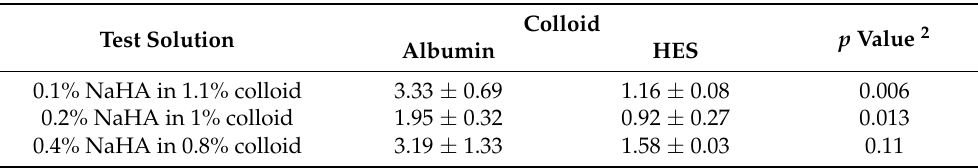
Table 1. Relative time 1 at which relative Orange G absorbance reached 0.3 as it permeated into